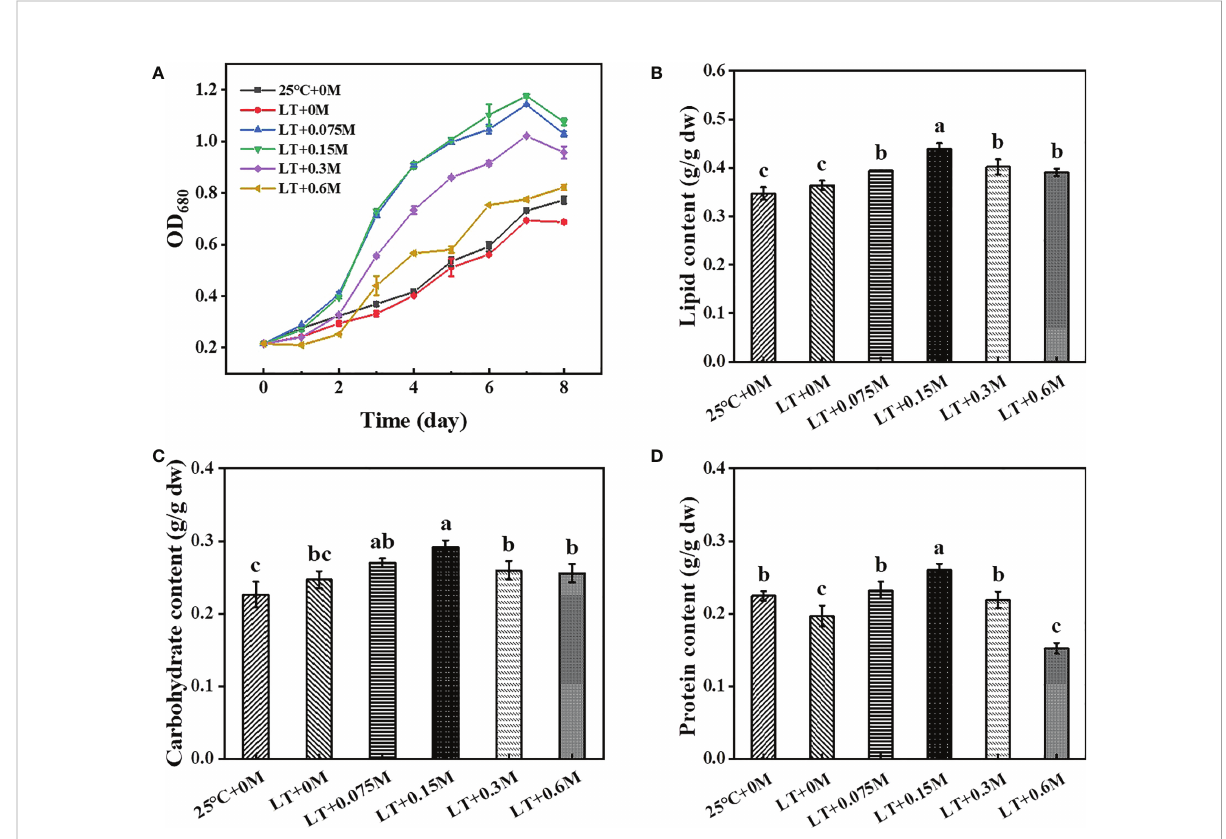
FIGURE 1 Effects of different combinations of bicarbonate and temperature on growth (A) and major metabolites ( B , lipid; C , carbohydrate; D , protein) accumulation in